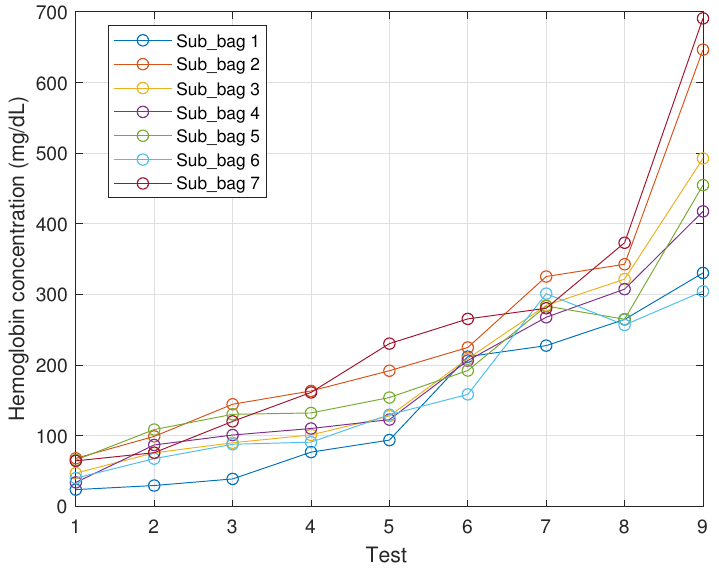
Figure 8. Hemoglobin concentration development of 7 sub-bags along 9 tests with the